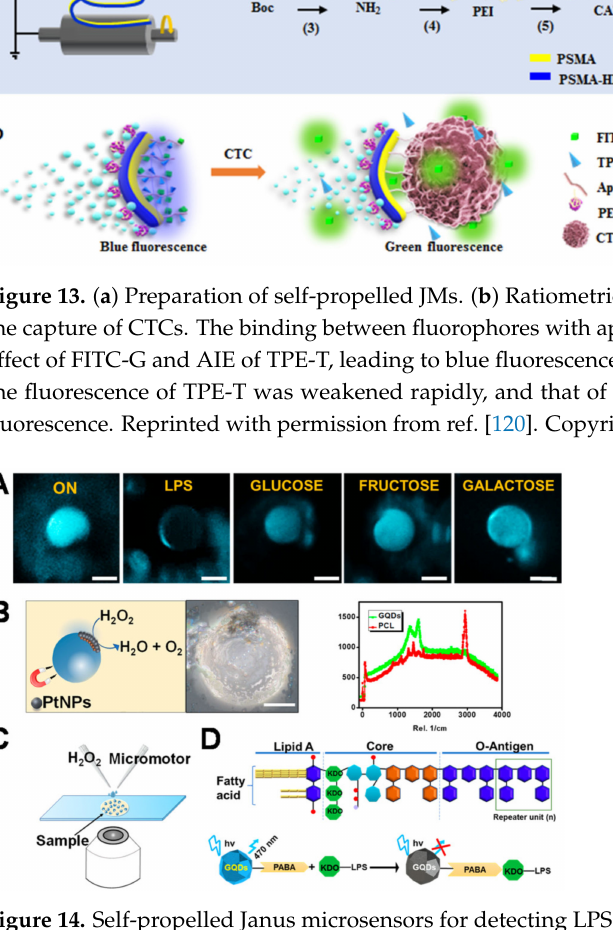
Figure 14. Self-propelled Janus microsensors for detecting LPS from Salmonella enterica (serotype enteritidis). ( A ) Real-time optical visualization of the LPS recognition event: time-lapse FL fluo- rescent images of the micromotors before (ON) and after LPS addition (OFF) and selectivity of the protocol in the presence of interfering saccharides. ( B ) Schematic of the microsensor operation and characterization. Optical images and Raman mapping show the distribution of nanoparticles, GQDs, and polycaprolactone (PCL) in the microsensor and corresponding Raman spectra. ( C ) Schematic of the setup for the Janus micromotor-based sensing protocol. ( D ) Schematics for the structure of the LPS from Salmonella enterica and mechanism of quenching by LPS union to the quantum dot (GQDs) recognition units contained in the microsensors. Reprinted with permission from ref. [126]. Copyright © 2018 American Chemical